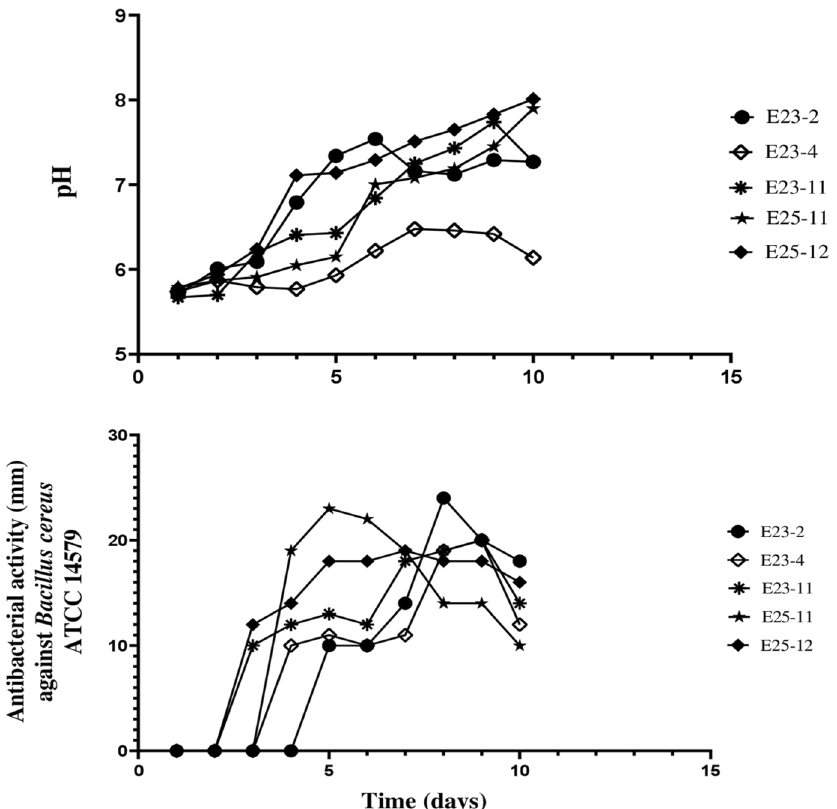
Figure 8. Kinetics of pH evolution and production of antibiotics against Bacillus cereus ATCC